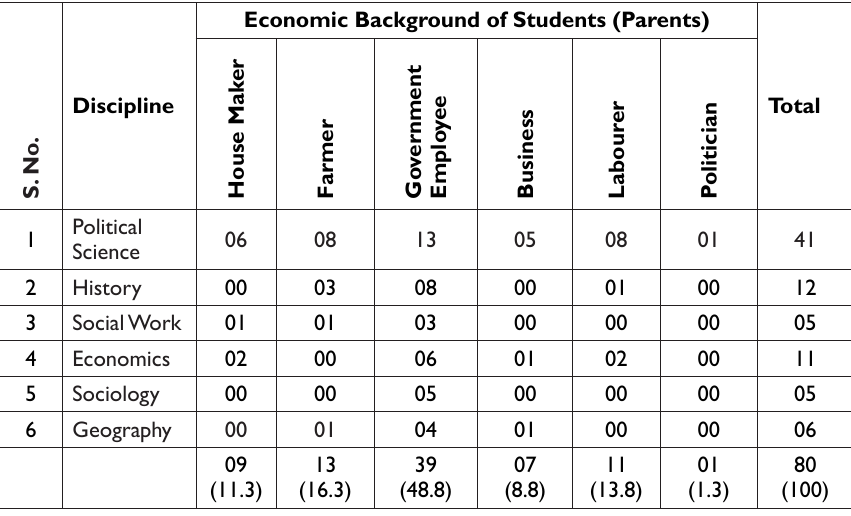
Table 1: Composition of students’ economic backgrounds in University of Delhi (N = 80)